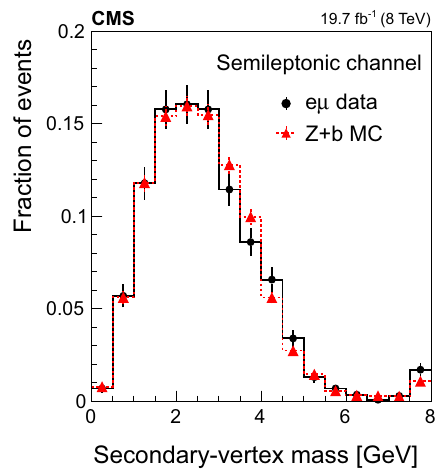
Fig. 6 Distributionofthecorrectedsecondary-vertexmassnormalized tounityfromsimulatedZ + bande μ -tt data(describedinthetext)events. Vertical bars represent the statistical uncertainties. The last bin of the distribution includes events with M corr vertex > 8GeV